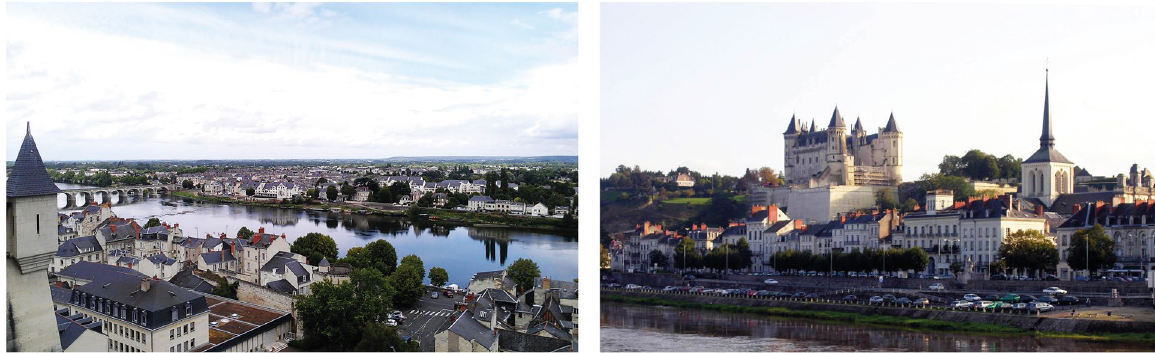
Fig. 1 Landscapes of the Loire Valley, city of Saumur. (Source: left, Liang Peng; right, Alain Marinos)